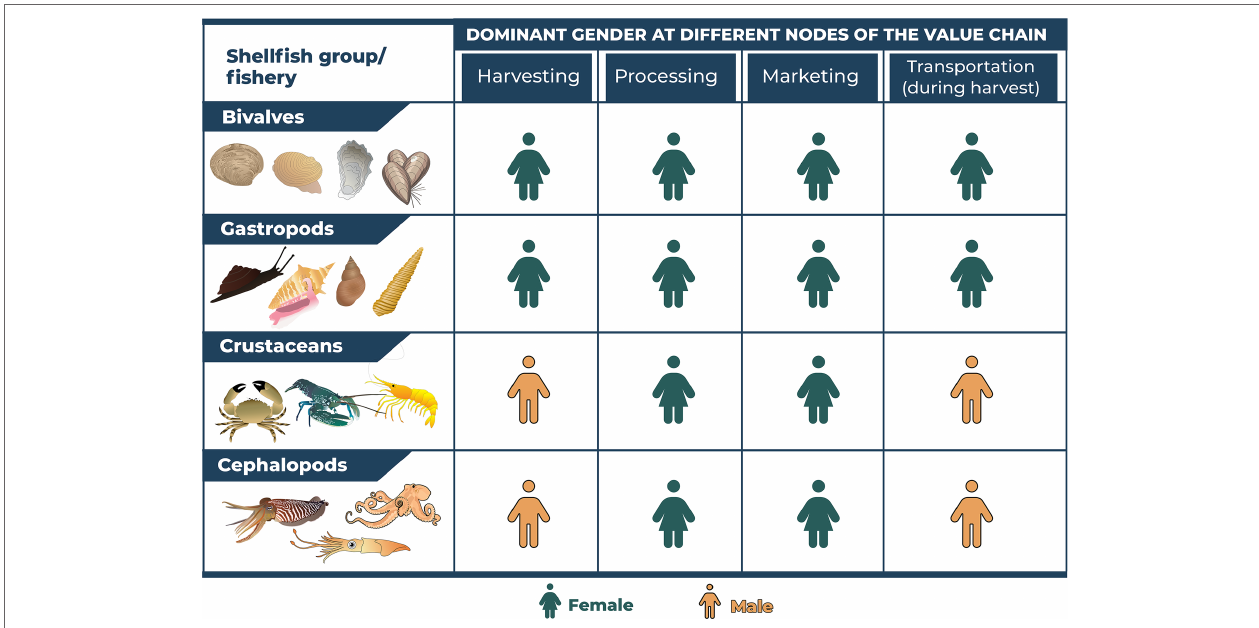
FIGURE 3 | Gender dominance of shellfish harvesters along the value chain of different shellfisheries along the West African coast. Gender dominance is determined by more than 60% participation by a particular gender. [Infographic developed originally by this study. Data source: Resource user survey from this study].